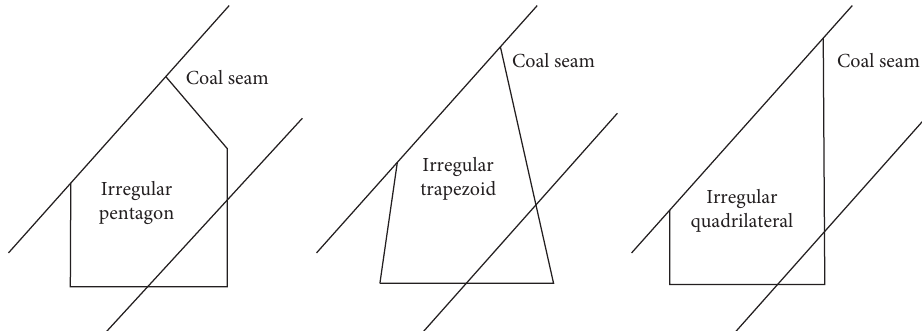
Figure 1: Schematic diagrams for typical abnormal roadway cross-sections.